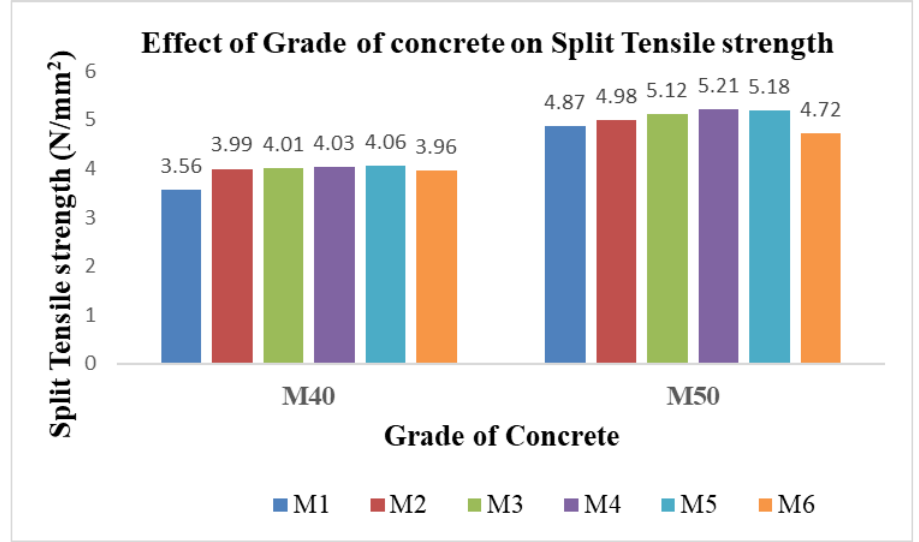
Figure 8. Comparison of the split tensile strengths of various specimens of different grades.